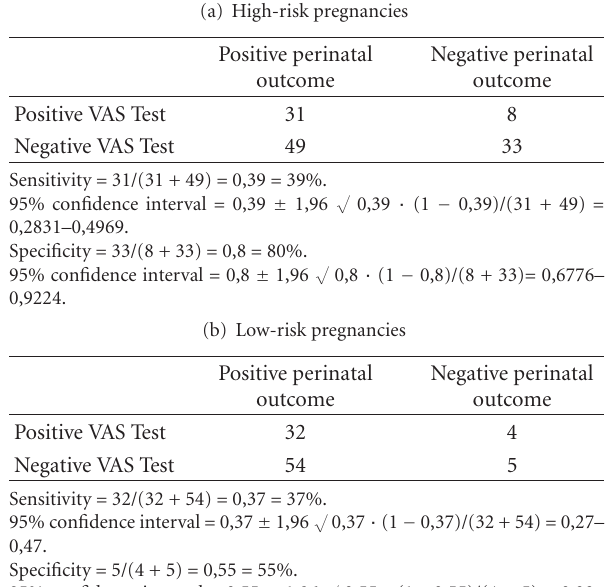
Table 6: Sensitivity and specificity